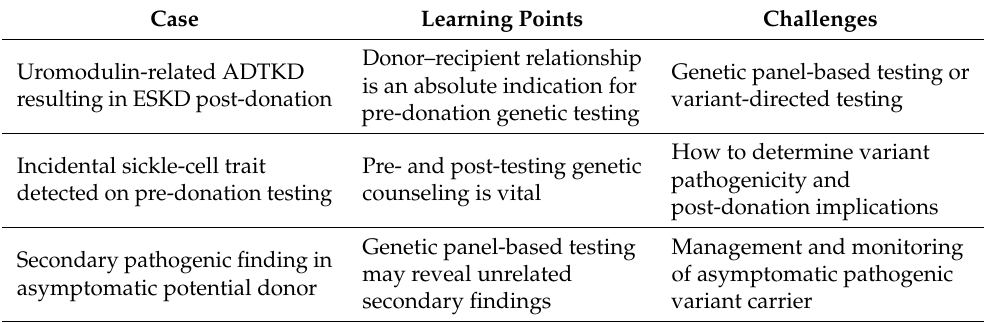
Table 1. The three illustrative cases and key challenges/learning points